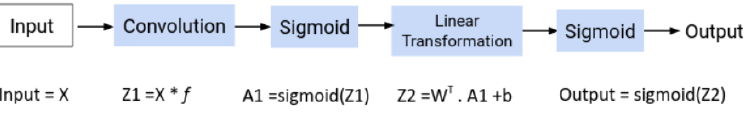
Figure 6. CNN mathematical format.